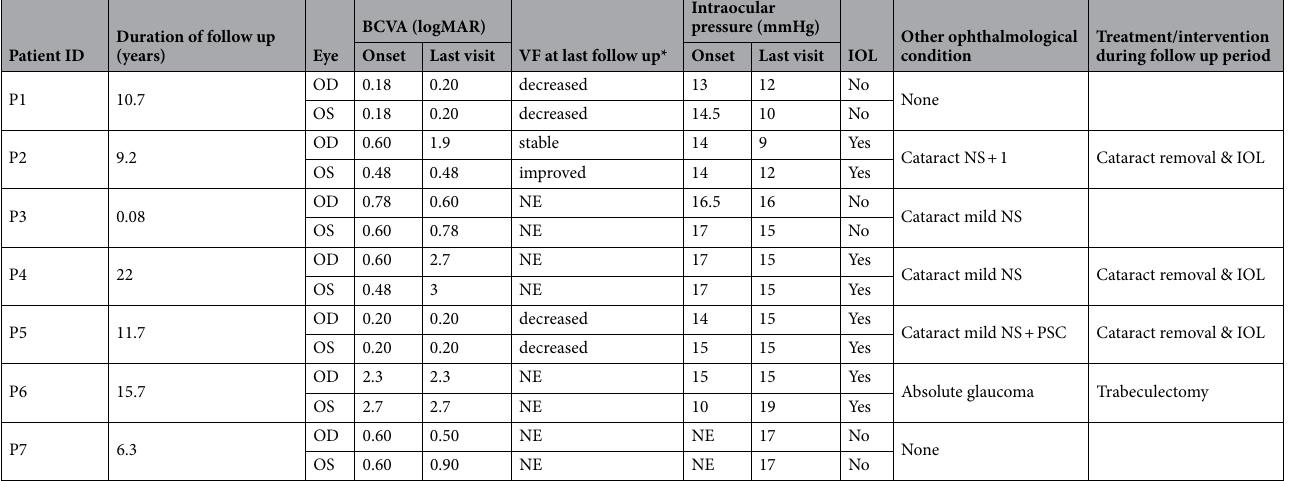
Table 3. Follow up clinical manifestation. *In comparison to baseline clinical data. BCVA, best corrected visual acuity; IOL, intraocular lens; logMAR, logarithm of the minimum angle of resolution; NE,